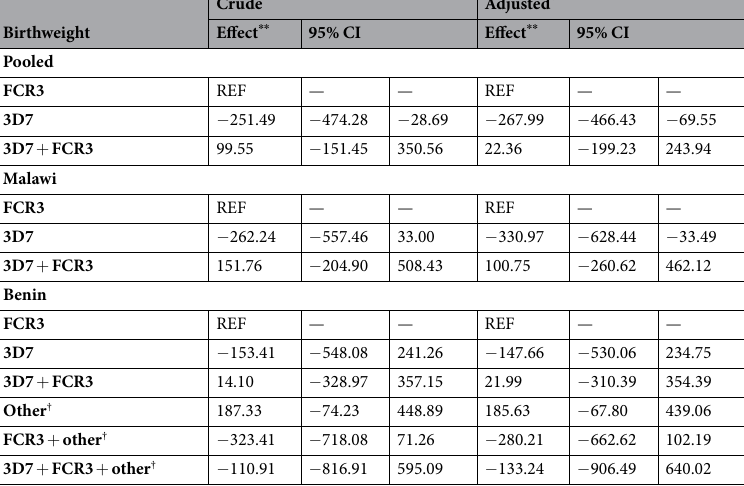
Table 3. Associations between ID1-DBL2x clades and infant birthweight (grams). * Adjusted for country (pooled analysis only) and parity using inverse probability weights (IPW). ** Change in infant birth weight (grams). † Other clade includes variants from clades identified only in